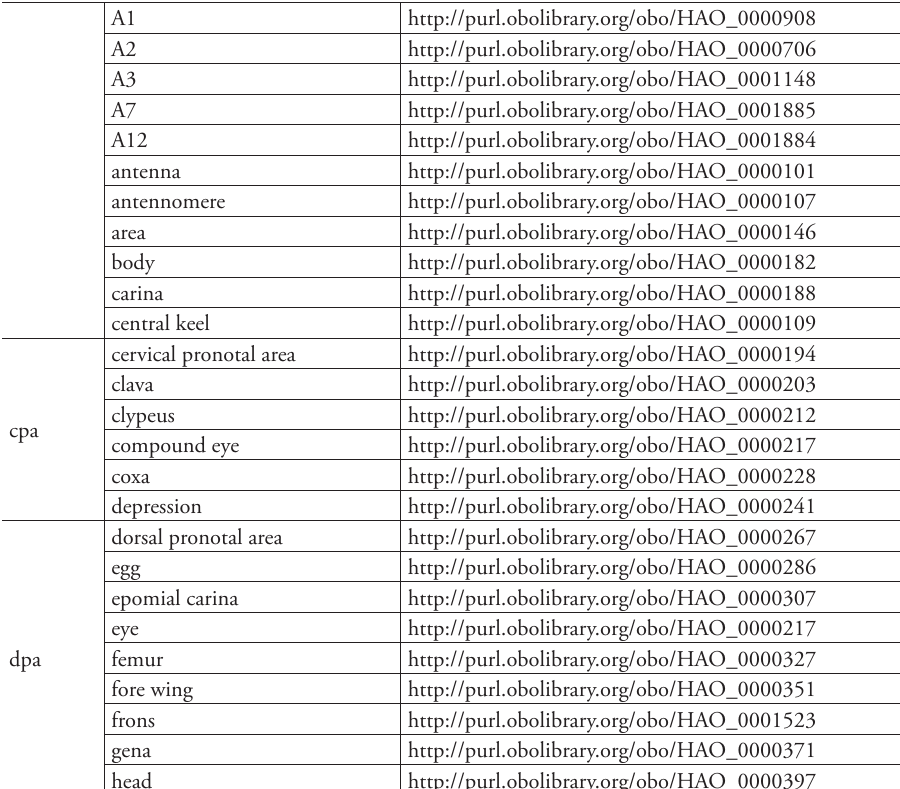
Table 1. URI Table matching terms and concepts used in this revision with the Hymenoptera Anatomy Ontology